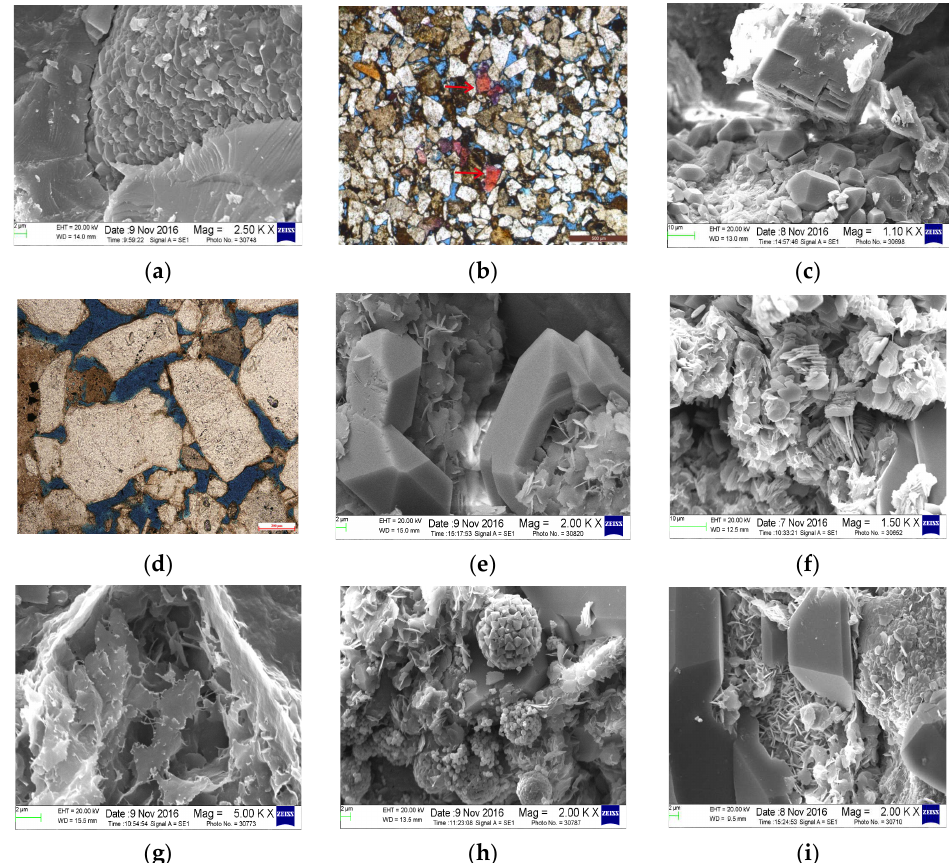
Figure 15. Cementing features. ( a ) Calcite; ( b ) Ferroan calcite; ( c ) Dolomite; ( d ) Secondary quartz; ( e ) Authigenic quartz; ( f ) Kaolinite; ( g ) Filiform Illite; ( h ) Pyrite; ( i ) Coniferous chlorite and Filiform Illite.